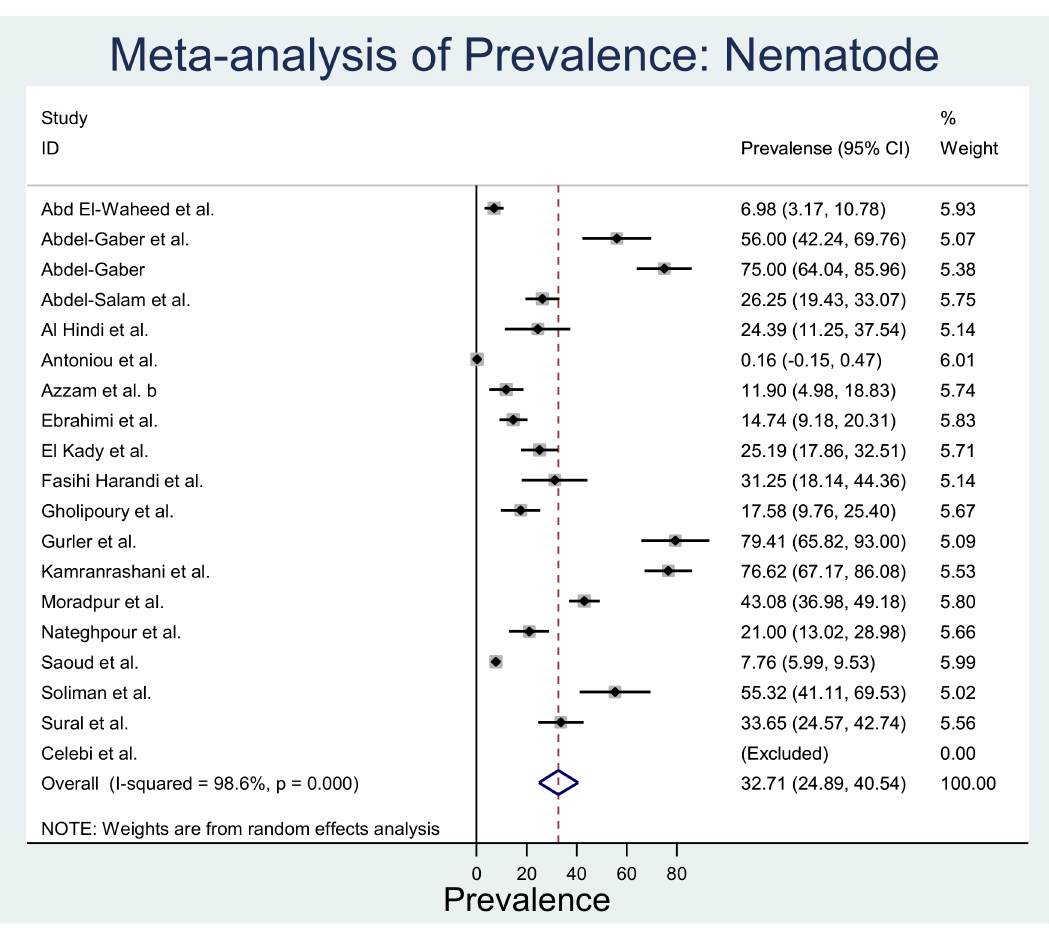
Figure 4. Forest plot of the prevalence estimates of nematode in rodents among the Middle East countries (the center dot representing point estimates whereas Gray Square representing the weight of each study to the